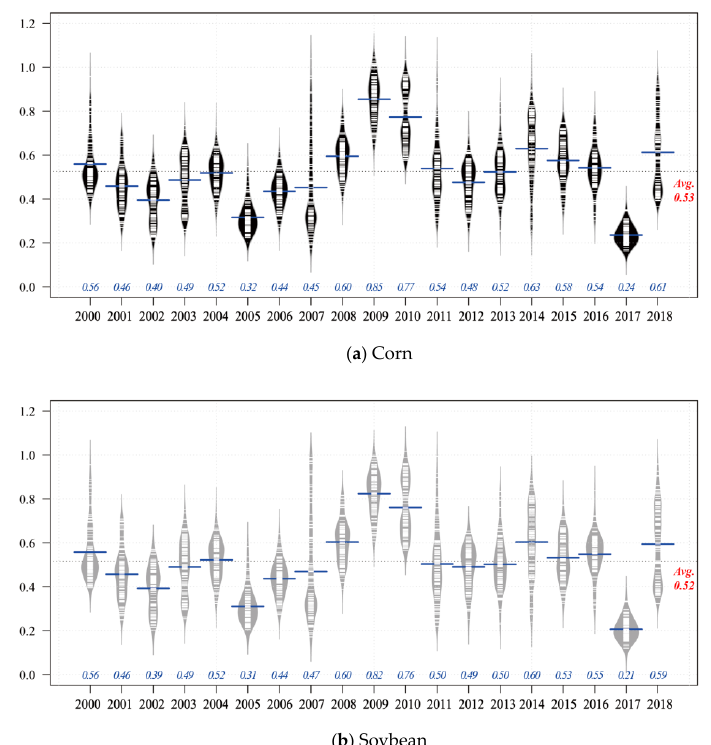
Figure 5. Temporal and regional changes in the rainfall effectiveness index for crop (REIC) for corn